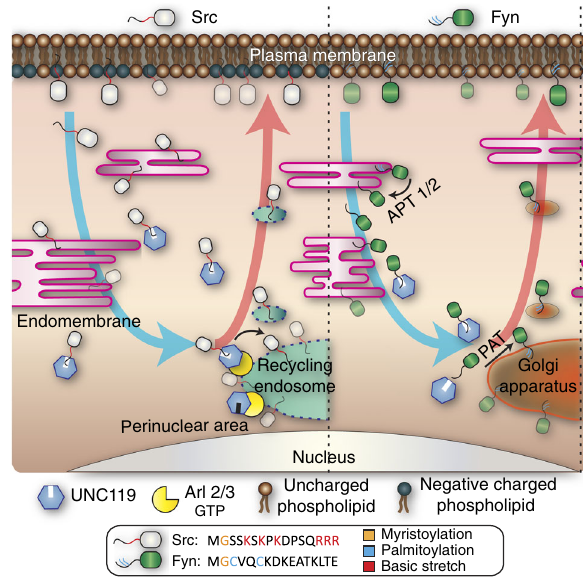
Fig. 8 Spatial cycles of Src and Fyn counter entropic equilibration to endomembranes to maintain their PM localisation. SFKs are displaced by endocytic processes and spontaneous dissociation from the plasma membrane and equilibrate with the vast endomembrane